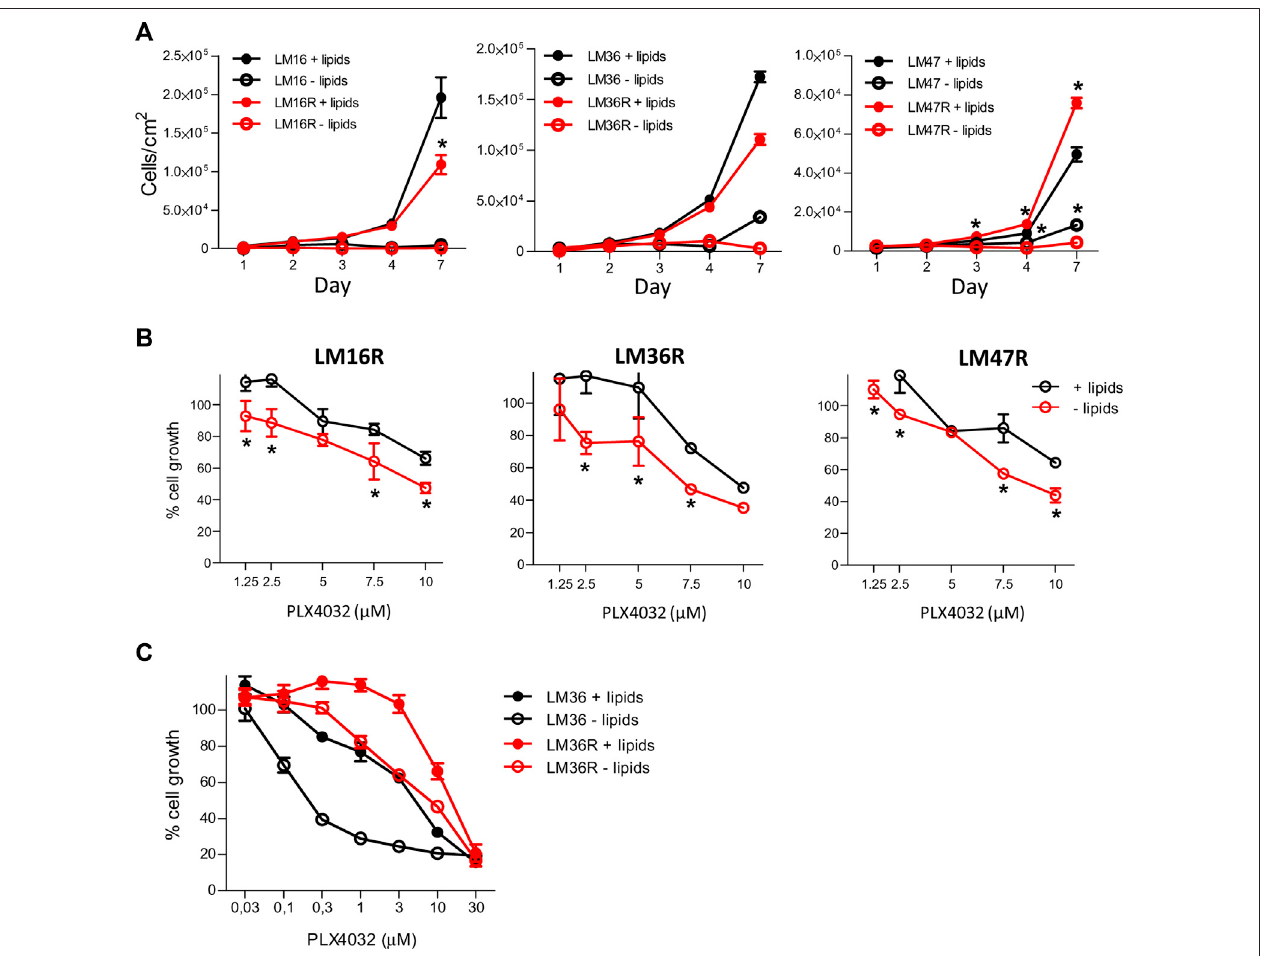
FIGURE 2 | Effect of lipid starvation on the growth of melanoma cells and on PLX4032 sensitivity. (A) . Cells were seeded at equal density (8 × 10 3 cells/well) in standardcultureconditions.After24 h,mediumwasreplacedwithlipid-freemediumandcellgrowthwasfollowedovertime.CellswerecountedusingaCoulterCounter at the indicated time points. (B) . Dose-response analysis by CCK8 assay after 48 h treatment with PLX4032 in standard medium and lipid-free culture conditions after having seeded cells at the density of 12 × 10 3 cells/well. In (A) and (B) * p values < 0.05 by two-way ANOVA followed by Bonferroni correction. (C) . Cell growth as detectedbyCCK8assayinLM36/LM36Rcellsafter48 htreatmentwithdifferentconcentrationsofPLX4032,andinpresenceorabsenceoflipids.TheIC 50 valueswere as follows: 4.5 and 14.6 μ M for LM36 and LM36R plus lipids, and 0.37 and 6.7 μ M respectively in lipid-free condition. All experiments were repeated three times and a representative experiment is